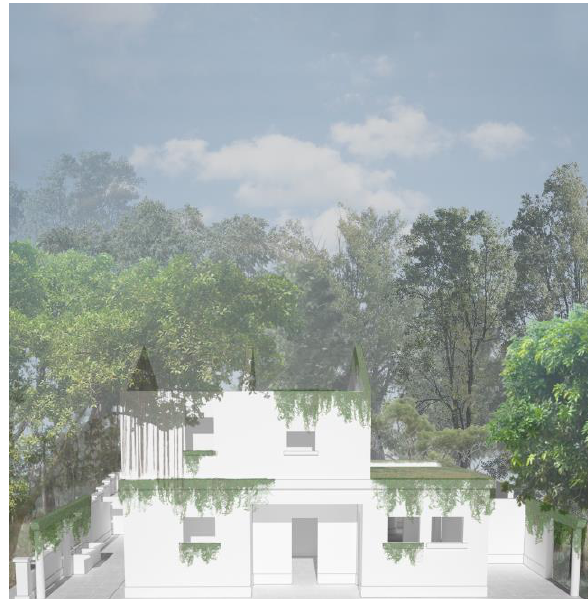
Figure 12. The Royal Park of Tirana. Render of the generator house.